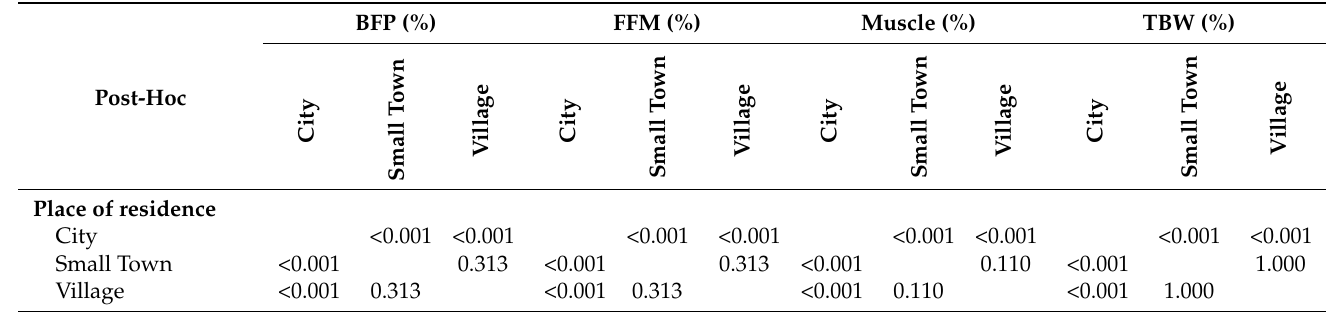
Table 5. The post-hoc test in reference to the difference between the body build parameters in relation to place of residence.